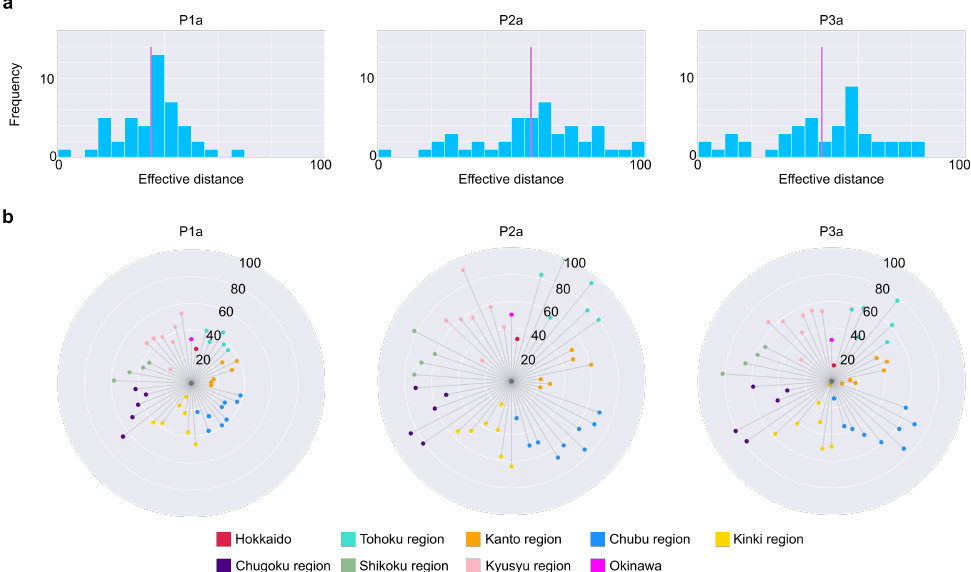
Figure 4. Effective distance changes dynamically depending on the stages of the pandemic. ( a ) Distribution of effective distances in periods P1a, P2a, and P3a. The vertical line in magenta indicates the mean value of the distribution. Prefectures whose effective distance is larger than 100 were excluded. ( b ) Effective distance of each prefecture in periods P1a, P2a, and P3a, ordered by “Prefecture Code” defined International Organization for Standardization. Regions to which prefectures belong are colored